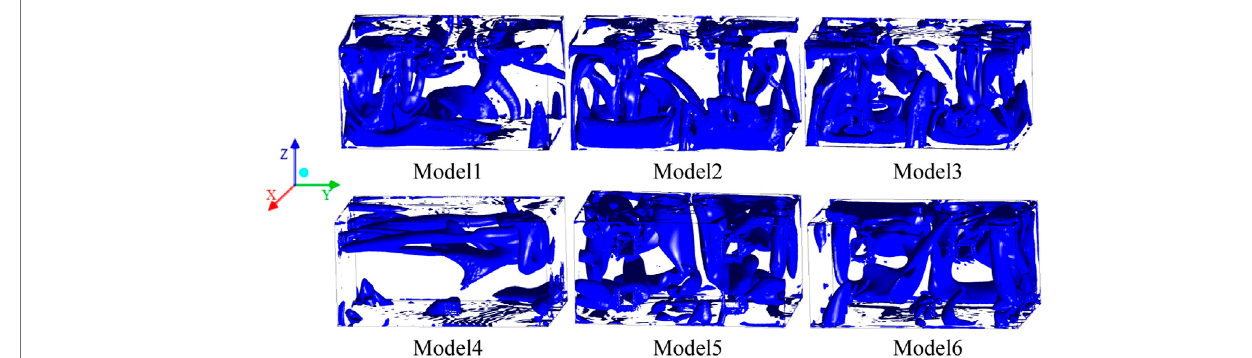
FIGURE 7 | Vortex core region distribution.